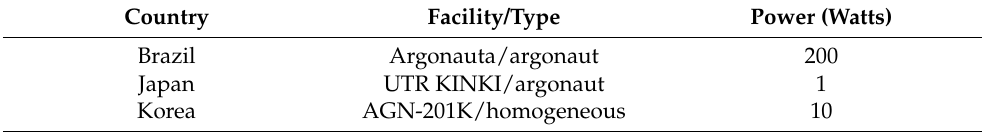
Table 1. Low power research reactors using neutron radiography according to RRDB [5].